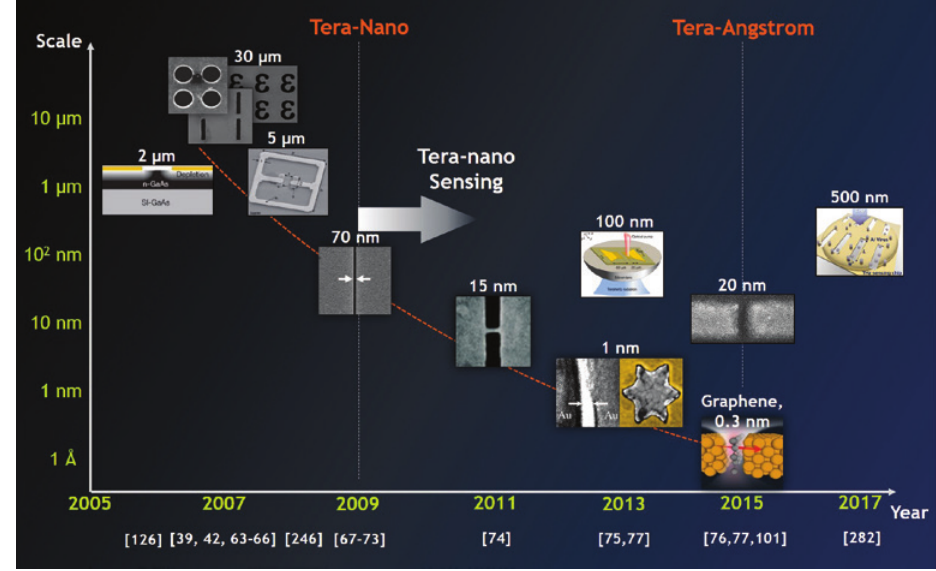
Figure 1: Achieved milestones in THz wave interaction with metallic structures down to the Angstrom